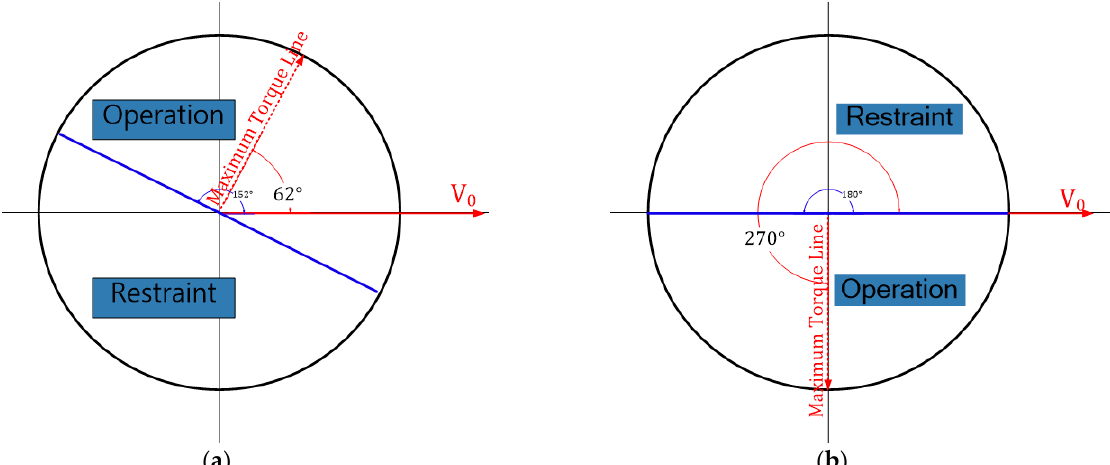
Figure 7. Threshold values of the zero-sequence angle differences: ( a ) m TF 0 θ for an SLG fault in a feeder; and ( b ) TB 0 θ for an SLG fault in a busbar.